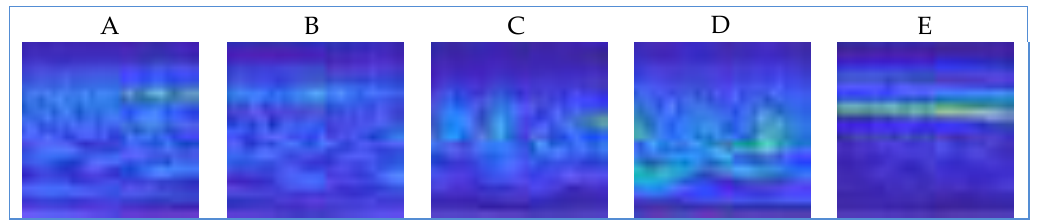
Figure 5. Sample scalogram changes of each segment for each set.